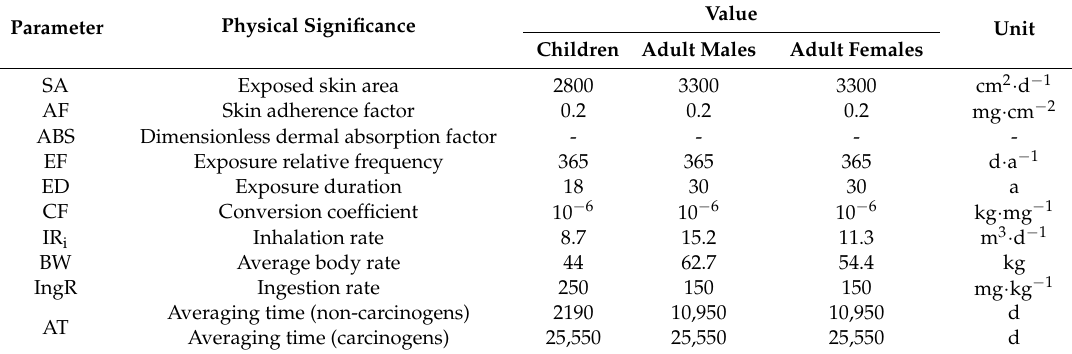
Table 3. The exposure parameter